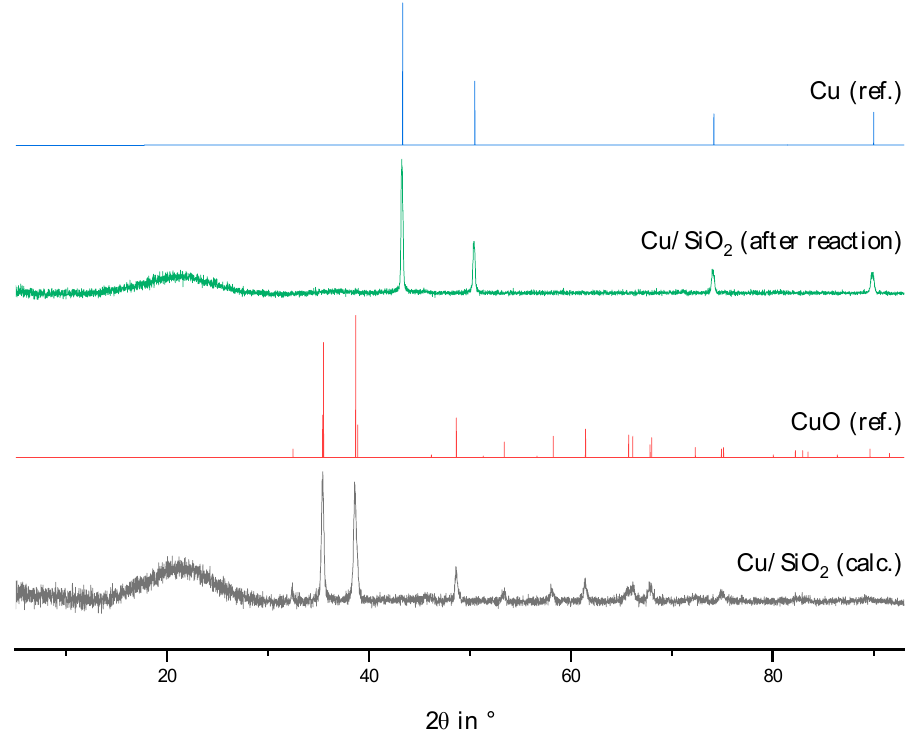
Figure A9. P-XRD of calcined copper catalyst before reaction (calc.) and after reaction.